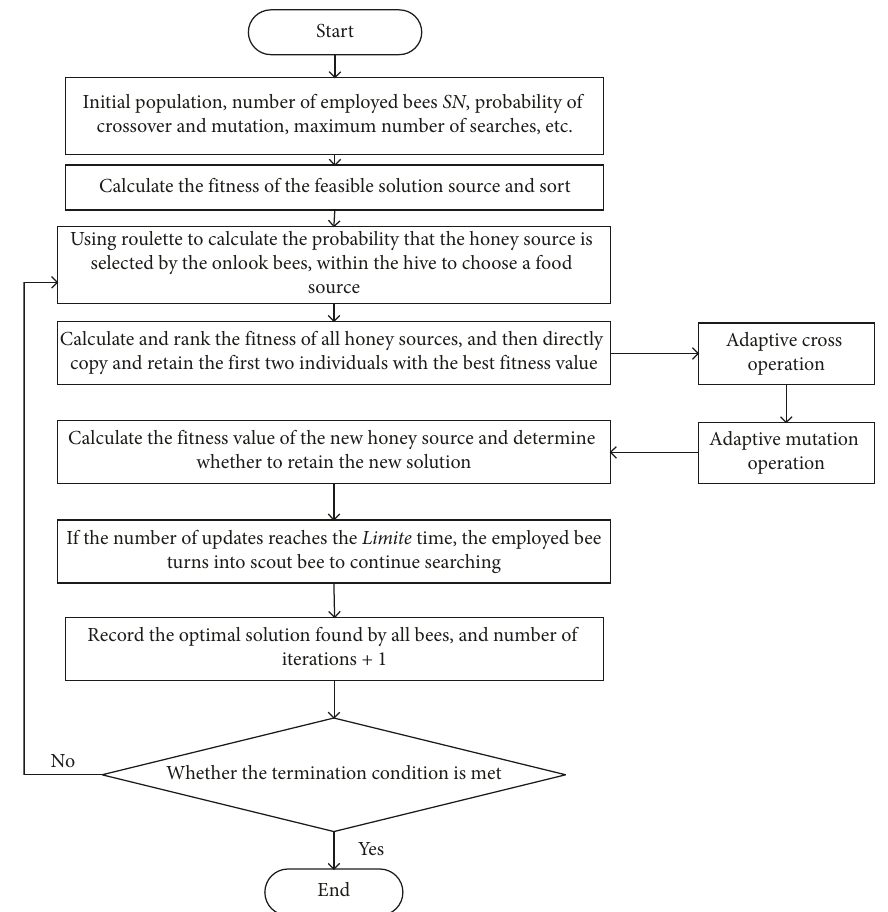
Figure 5: Improved artificial bee colony